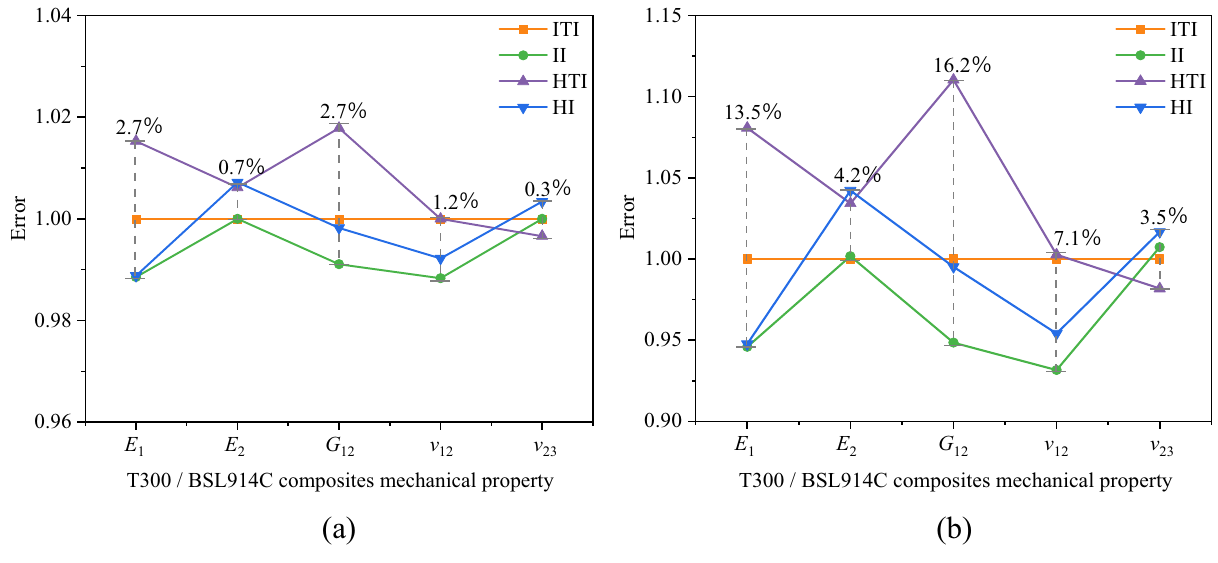
Figure 13: E ff ect of interphase thickness on the composite elastic property parameter calculation errors: ( a ) the e ff ect of interphase type on composite elastic properties with the interphase thickness of 0.1 μ m, and ( b ) the e ff ect of interphase type on composite elastic properties with the interphase thickness of 0.5 μ m.